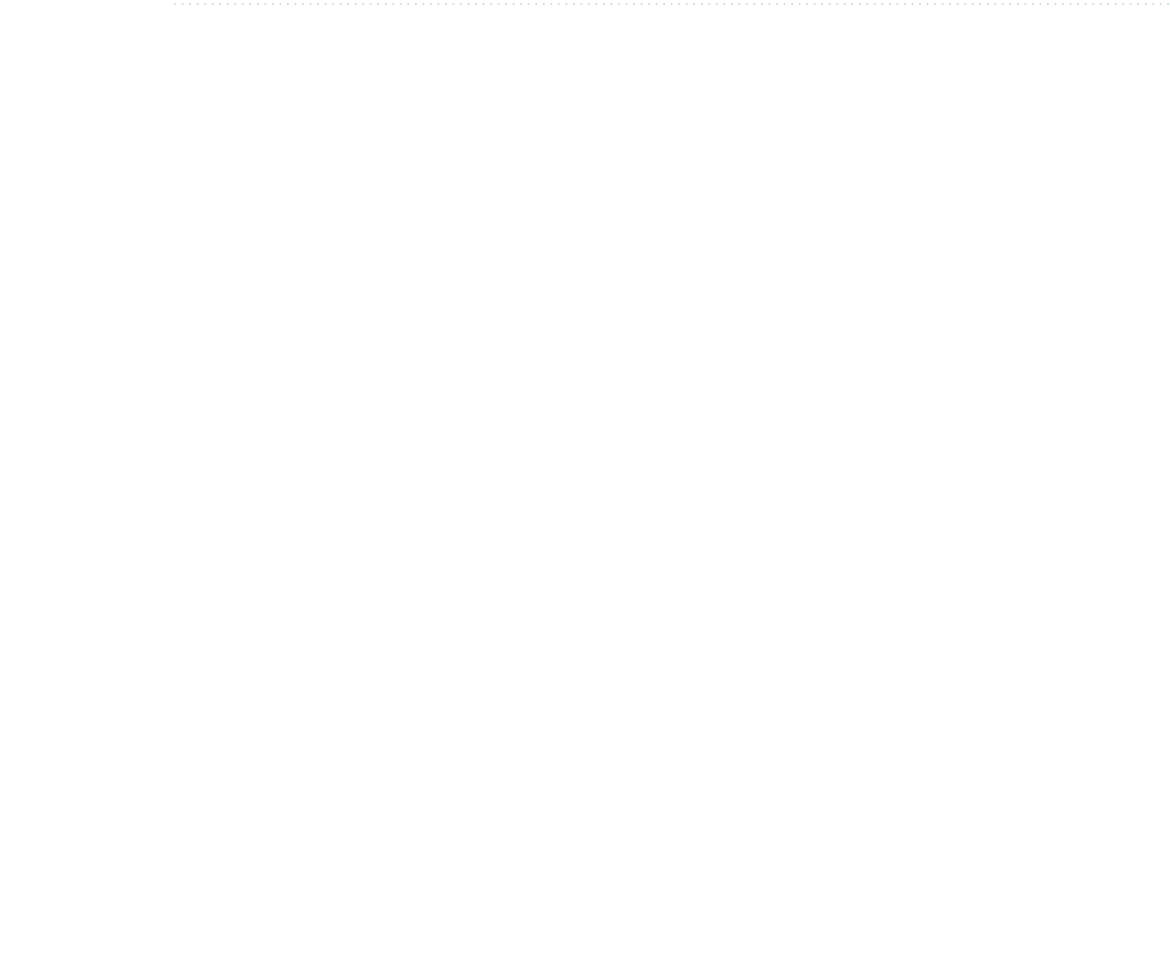
Figure 20. Velocity contours for cough = 20 m/s and ventilation = 1